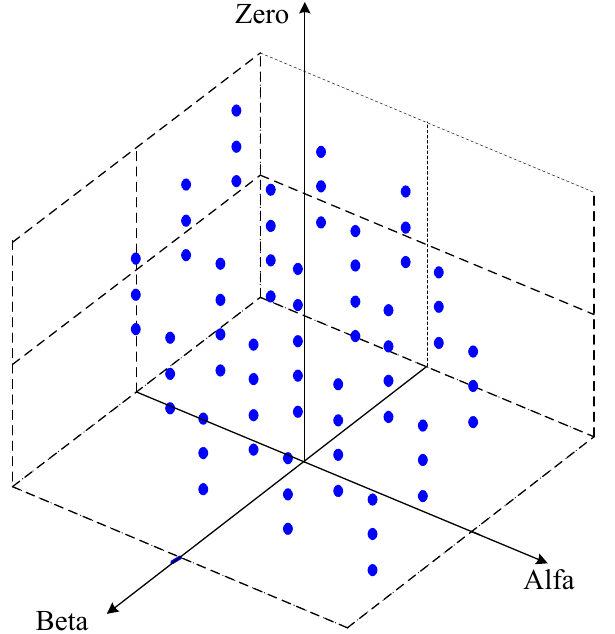
Figure 3. Voltage vectors that can be applied at the output of the proposed converter in the three-dimensional space ( αβ o coordinates).